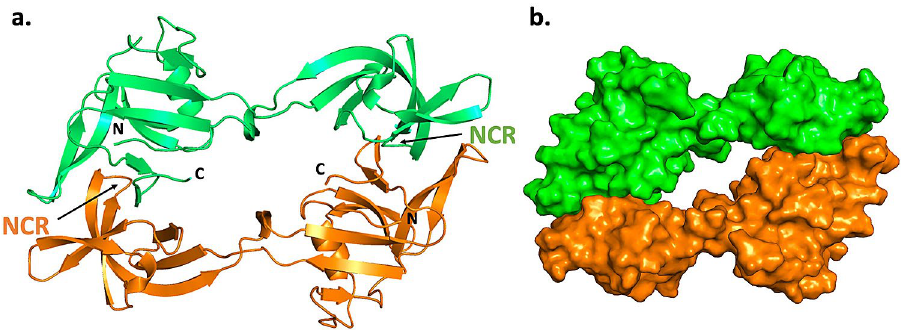
Figure 5. Crystal structure of the Pho PolII intein as a domain swapped dimer. ( a ) Ribbon diagram of the two monomers of the Pho PolII intein with the N- and C-termini indicated (PDB code 5BKH). The data begin at N-extein residue Arg-3 to C-extein residue Cys + 1. The non-conserved region (NCR) is shown on each monomer. ( b ) Van der Waals representation of the Pho PolII intein precursor, colored by chain, to demonstrate the dimer interface. Figures were made with PyMOL